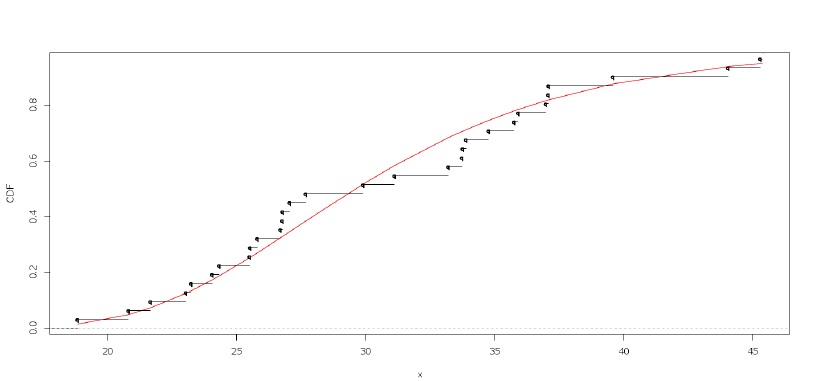
Figure 5 – TTT plot for endurance of deep groove ball bearings data.